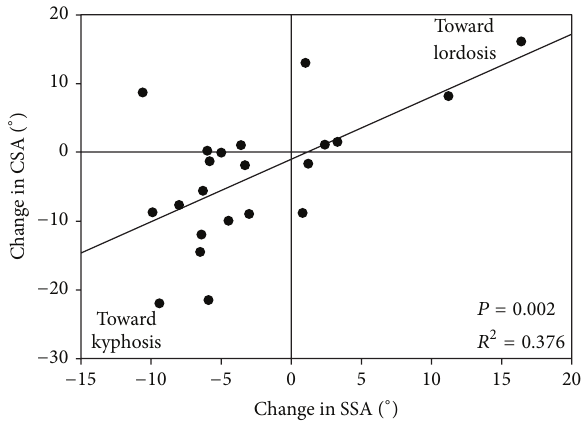
Figure 4: Correlation between SSA and CSA after ACD with implantation of Sulcem PMMA spacers. The diagram shows the positive correlation between SSA and CSA in the Sulcem PMMA group indicating that a change in SSA was a significant predictor of a change in CSA. The mean change in SSA was − 2.4 ∘ and in CSA was − 5.2 ∘ . ACD: anterior cervical discectomy, CSA: cervical sagittal alignment, PMMA: polymethylmethacrylate, and SSA: segmental sagittal